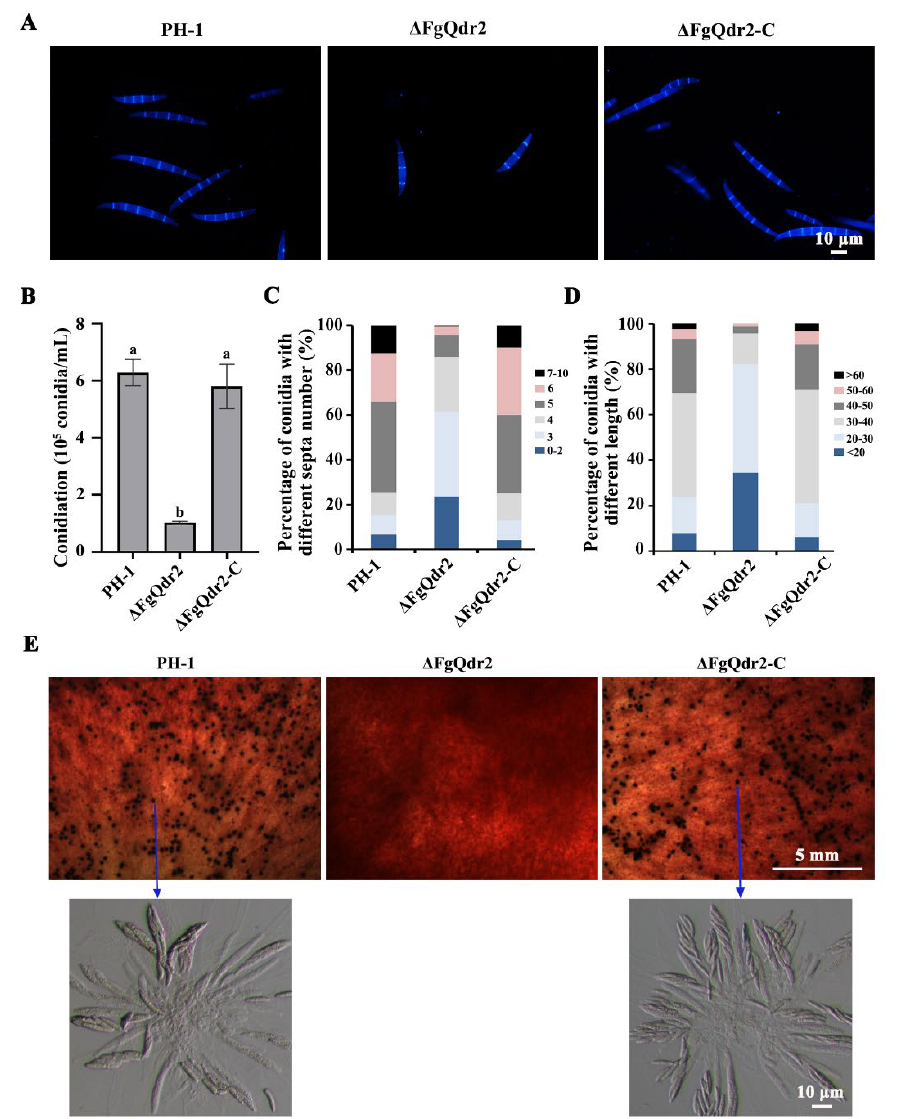
Figure 6. The deletion of FgQDR2 resulted in defects in sexual and asexual reproduction in F. graminearum . ( A ) The spores of the wild-type and ∆ FgQdr2 were stained with calcium fluorescent white (CFW). Bar = 10 µ m. ( B ) The number of conidia produced by each strain. ( C ) The number of spore septa in each strain. A total of 200 conidia were examined for each strain. ( D ) The spore length in each strain. A total of 200 conidia were examined for each strain. ( E ) Deletion of FgQDR2 leads to sexual reproduction defects in F. graminearum .